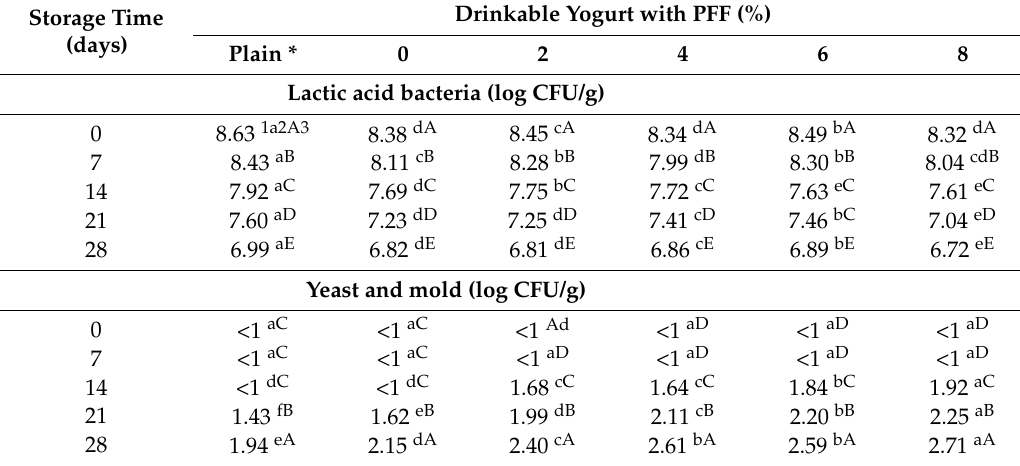
1 Data represent mean values for each sample ± standard deviation ( n = 3). 2 Means followed by different lower case letters within a row show difference between drinkable yogurts ( p < 0.05). 3 Means followed by different